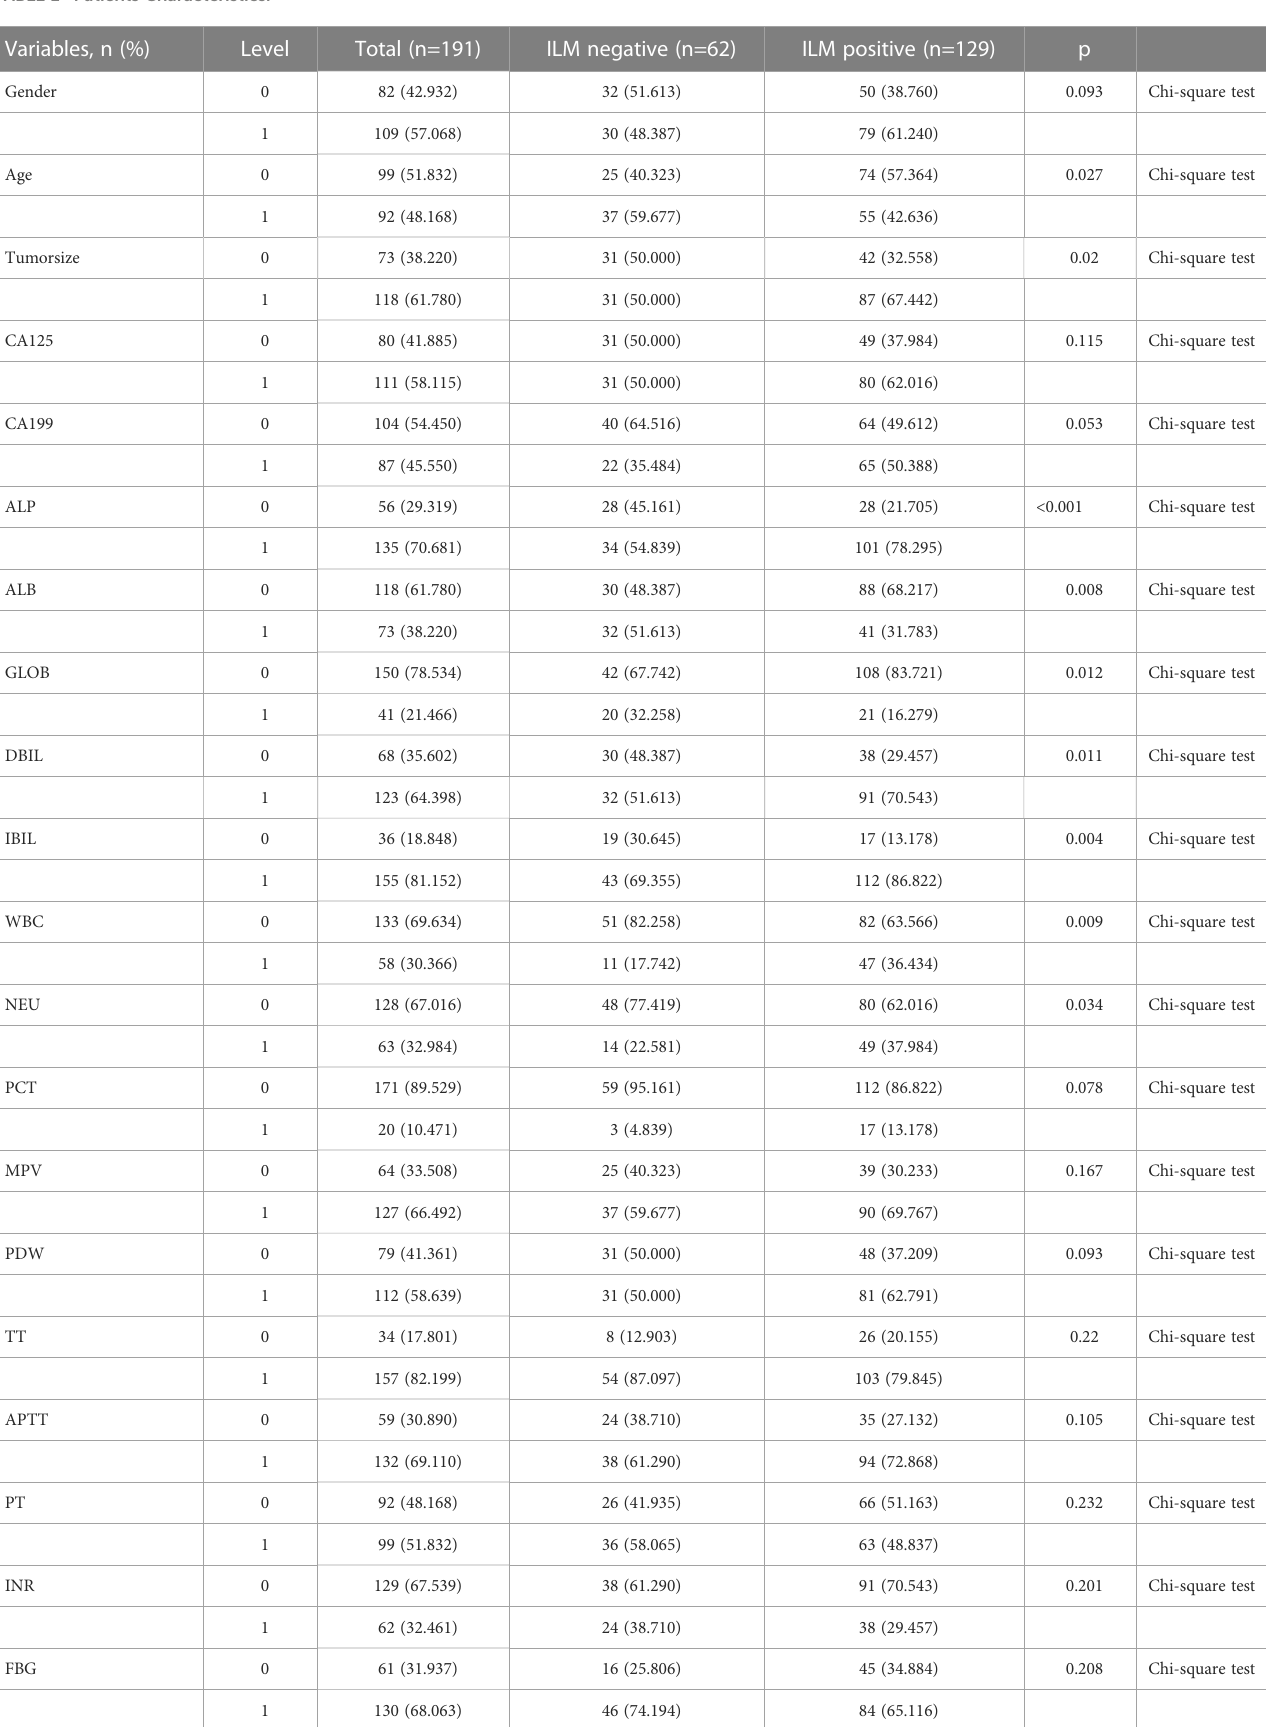
TABLE 1 Patients